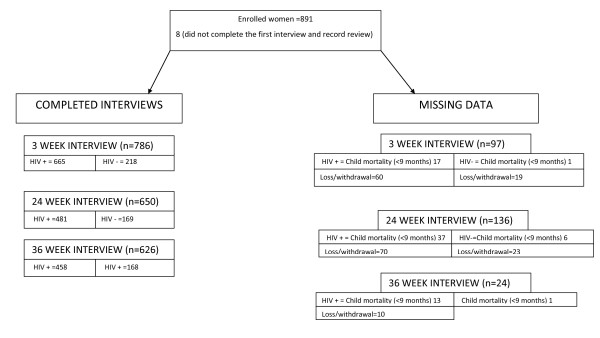
Study profile. The left hand side of the figure above indicates all completed interviews at different interviewing periods. The positive and negative sign (+/-) indicates HIV positive and negative women respectively. The right hand side of the figure indicates all missing data which was a result of either mother moving or withdrawal from the study and child mortality.